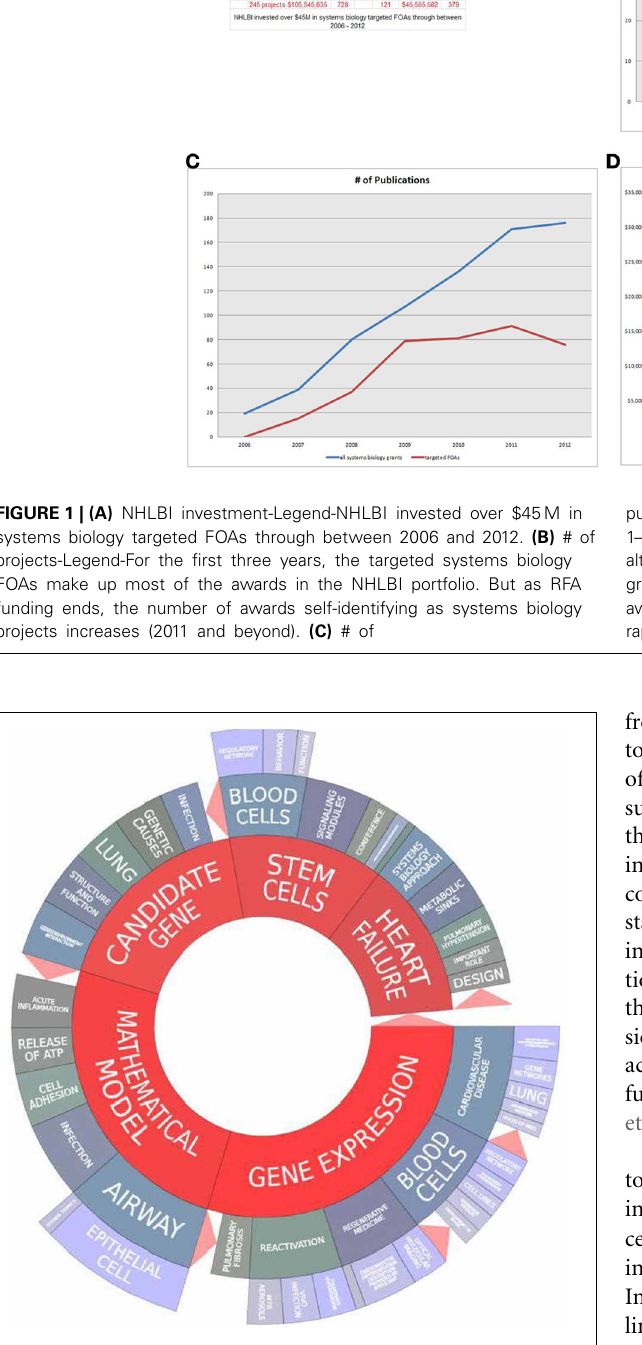
FIGURE 2 | NIH Reporter visualization of themes across the NHLBI systems biology portfolio